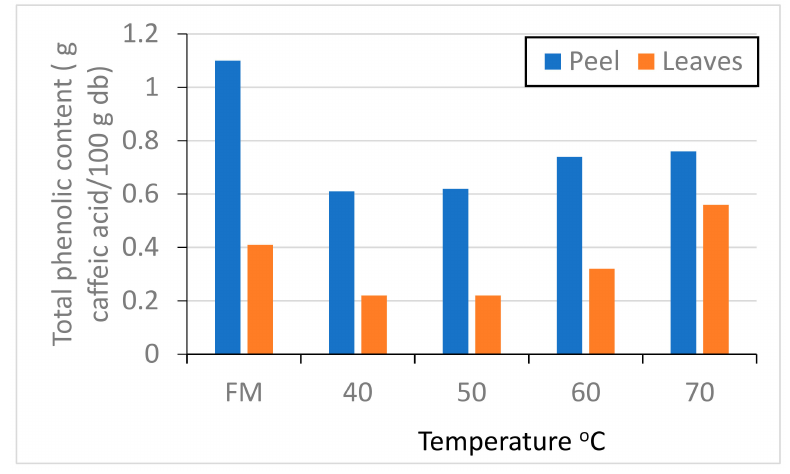
Figure 6. E ff ect of infrared temperature on total phenols of orange peel and leaves. Table 2. E ff ect of FIR-radiation and heat treatments on total phenolic contents of water extract from peanut hulls